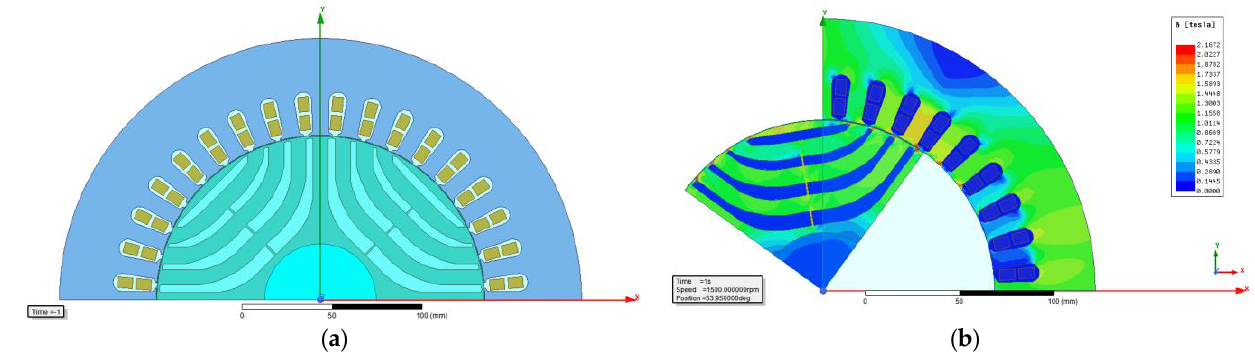
Figure 4. Fine − tuned SynRM: ( a ) Overview; ( b ) Magnetic flux density.